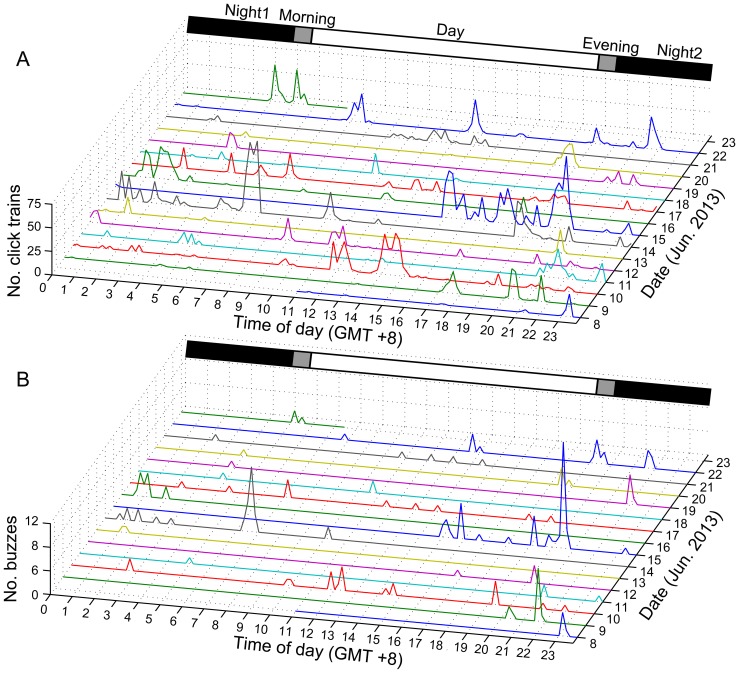
The daily occurrence of porpoise click trains (A) and buzzes (B) by diel phase and time of day.The data were grouped into 10(hour GMT +8).